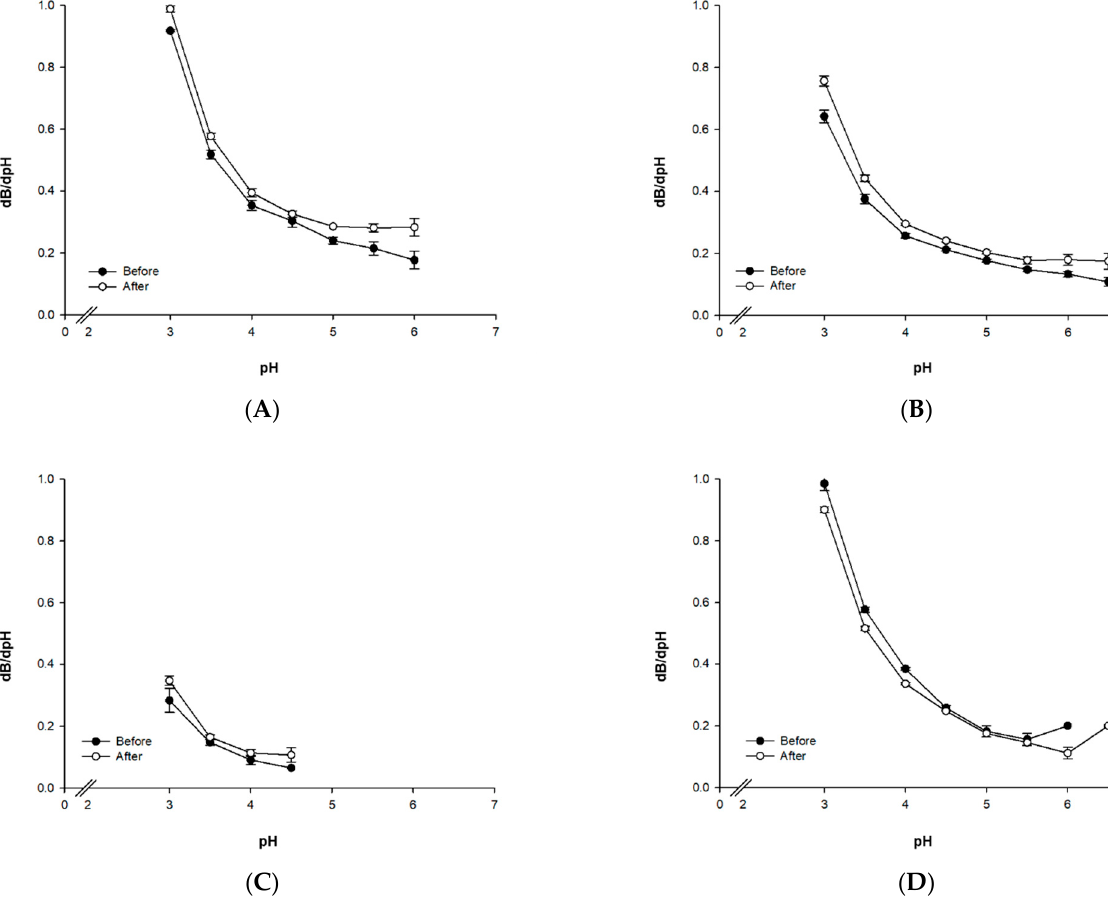
Figure 2. Buffering capacities of plant protein solutions (5%, w / w ) before and after the physical treatment (pasteurization and homogenization): ( A ) isolated soy protein (ISP), ( B ) pea protein (PP), ( C ) rice protein (RP), and ( D ) almond protein (AP).